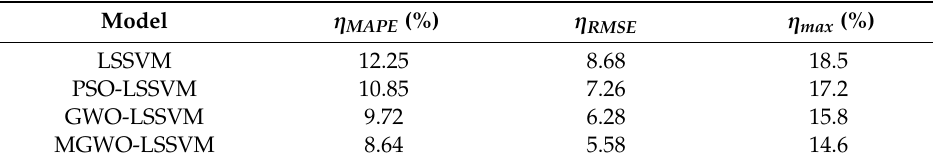
Table 3. Comparison of di ff erent prediction models.